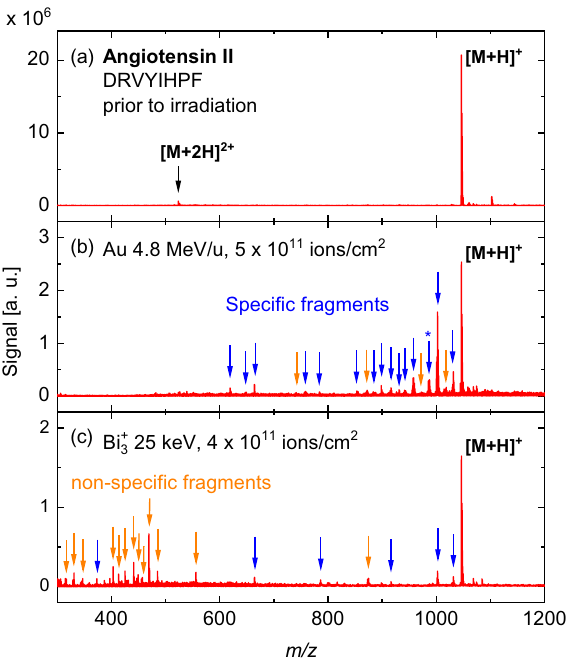
Figure 3. DINeC mass spectra (positive ion mode) from ( a ) a freshly prepared angiotensin II sample, ( b ) the same sample irradiated with 946 MeV Au ions, and ( c ) an angiotensin II sample irradiated with 25 keV Bi Fragment peaks with signal intensities higher than ≈ 3 % of the signal of the intact molecule are labeled with arrows. In the spectrum of the fresh sample, no fragment peaks are present. In the case of SHI irradiation, most peaks can be assigned to specific fragments (blue arrows). A fragment corresponding to double cleavage of the peptide backbone is also observed (indicated by a star). In contrast, the spectrum from the sample irradiated with keV ions shows mostly non-specific fragment peaks (orange arrows). In the m / z range below 300, no significant fragment peaks were observed (compare Fig. S2 in the Supporting Information). The difference in the noise level between ( b ) and ( c ) is within the fluctuation from sample to sample. The spectrum in ( c ) has been adopted from Ref. 21